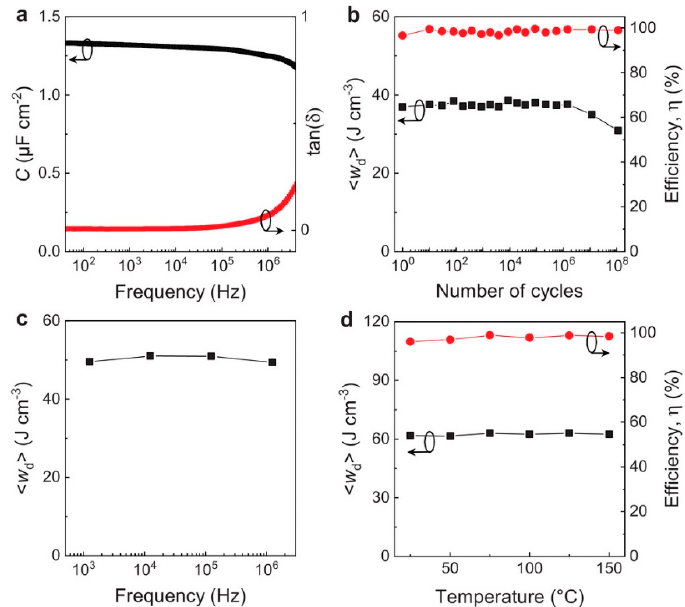
Figure 10. Plots of major factors with the stability of the capacitor composed with ferroelectric/dielectric stack. ( a ) Both capacitance density C (left) and loss factor tan ( δ ) (right) versus frequency without DC bias for frequency stability. ( b ) Discharged energy density 〈 W d 〉 (left) and efficiency (right) versus cycling times under 10.6 V for cycling stability. ( c ) 〈 W d 〉 versus frequency by pulse under 12.7 V for frequency stability. ( d ) 〈 W d 〉 (left) and efficiency (right) versus temperature